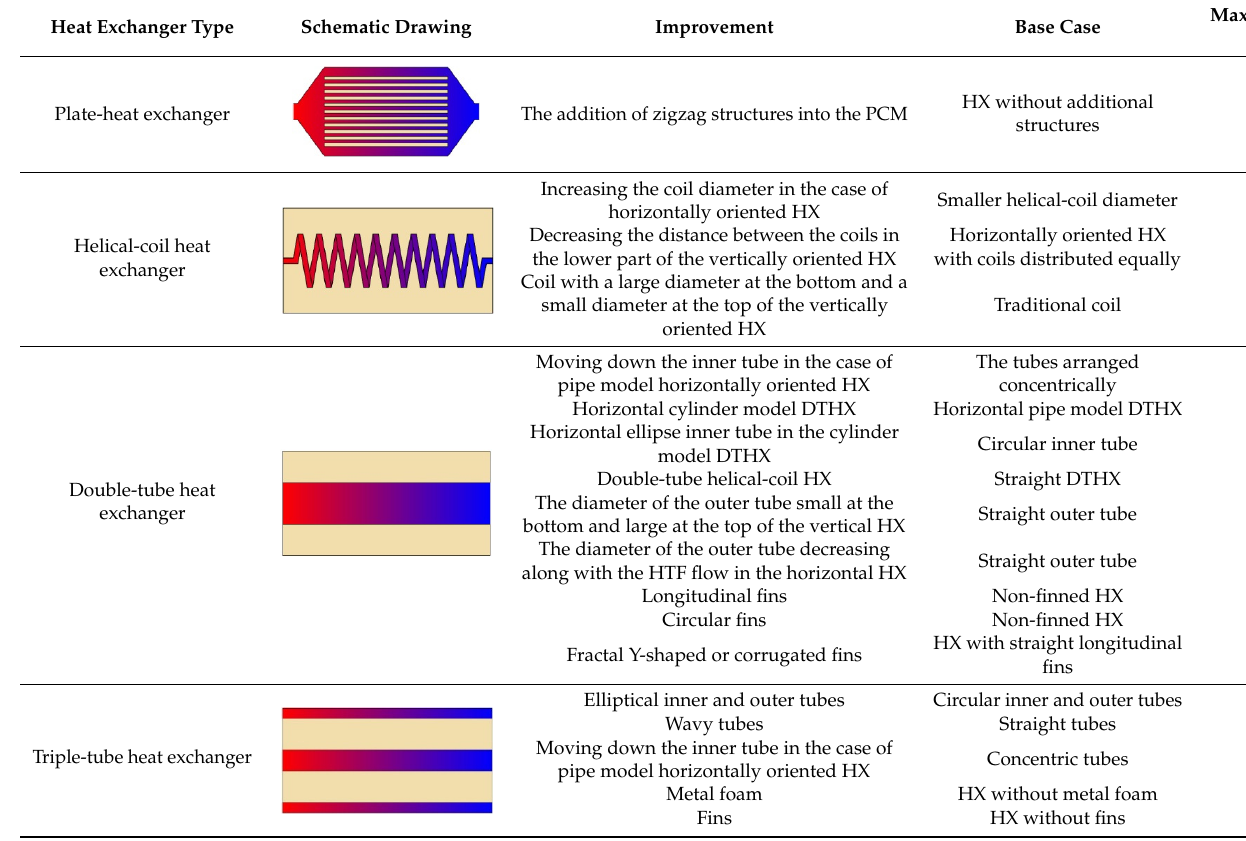
Table 10. Types of heat exchangers for PCMs and the main possibilities of phase change time reduction.